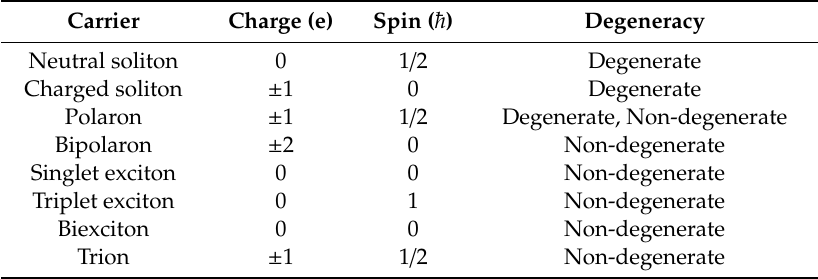
Table 1. Charge and spin relationship of organic carriers. Carrier Charge (e) Spin ( ¯ h )